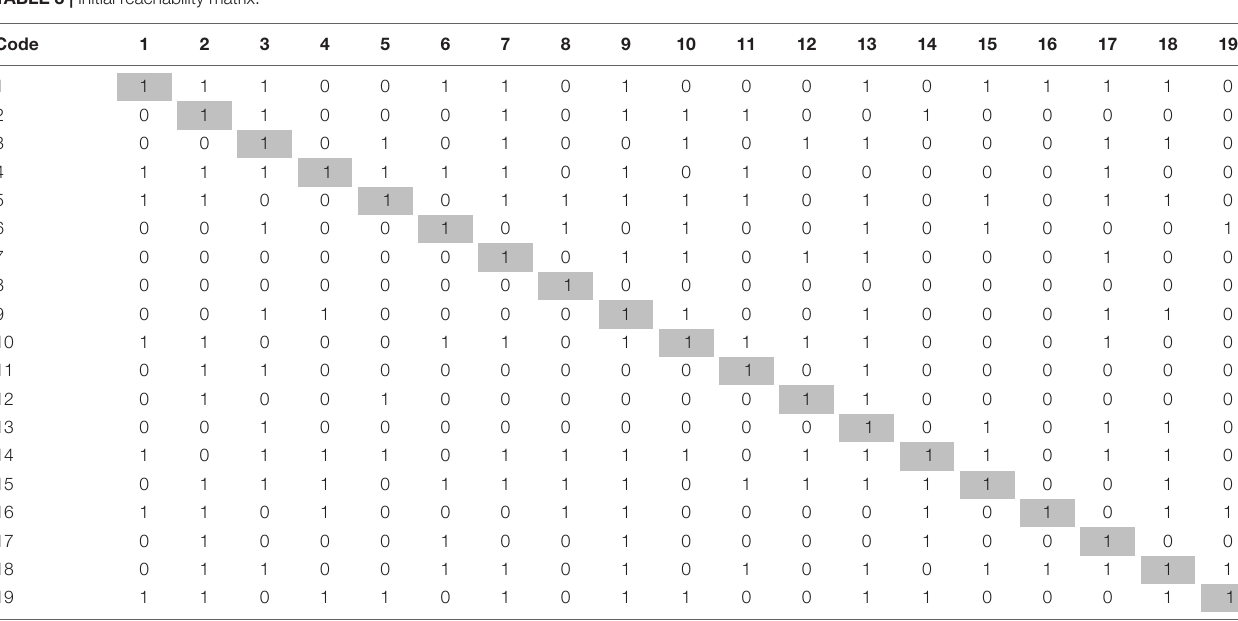
Shaded diagonal cells are ii part of the matrix that differentiates ij part of the matrix from ji.